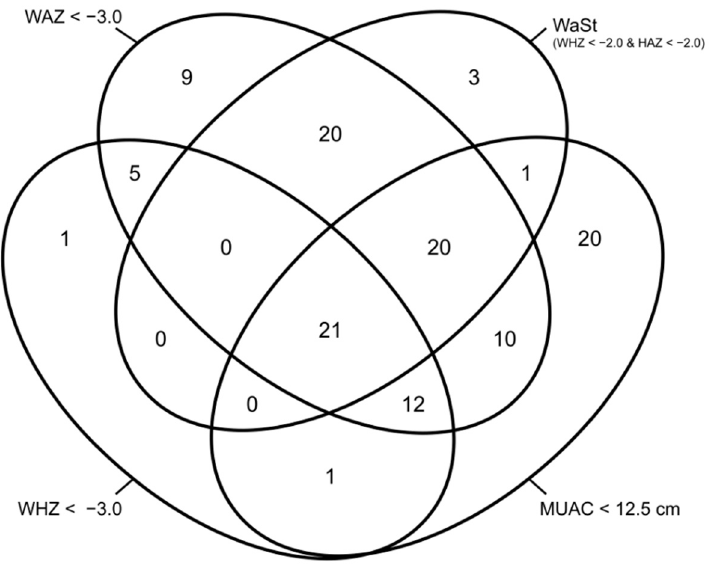
Figure 3. Venn diagram showing the number of deaths among treated children with different combinations of anthropometric deficits (adapted from Myatt et al., 2019 [19]). MUAC, mid-upper arm circumference; WAZ, weight-for-age z-score; WHZ, weight-for-height z-score; HAZ, height- for-age z-score; WaSt, both wasted and